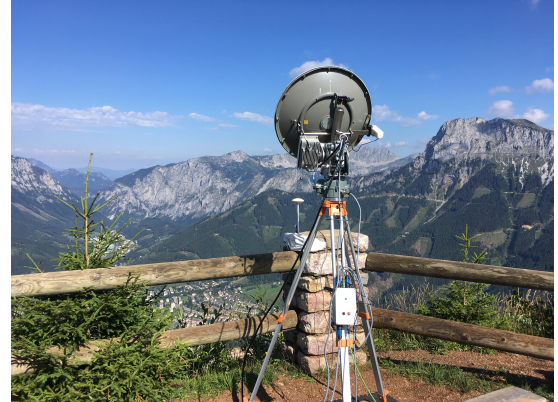
Figure 3. Ground antenna on top of the Erzberg (source: DLR (CC-BY